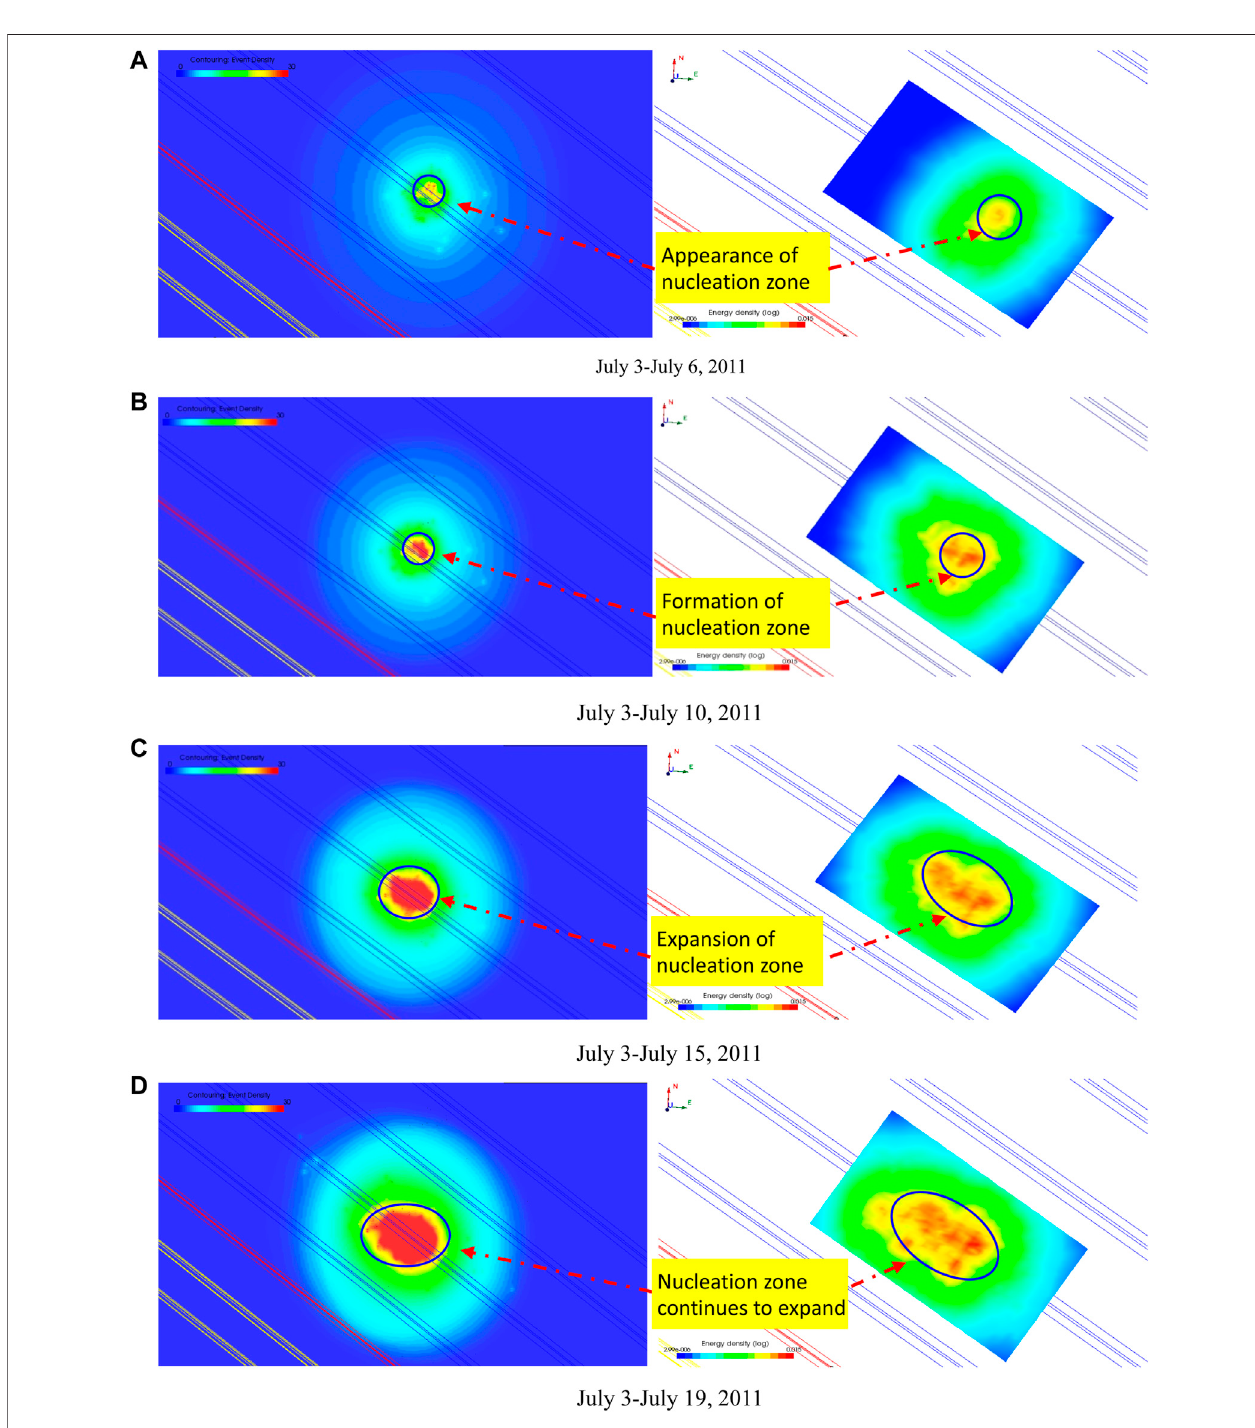
FIGURE 11 | Evolution contour of MS events density and energy density in diversion tunnel